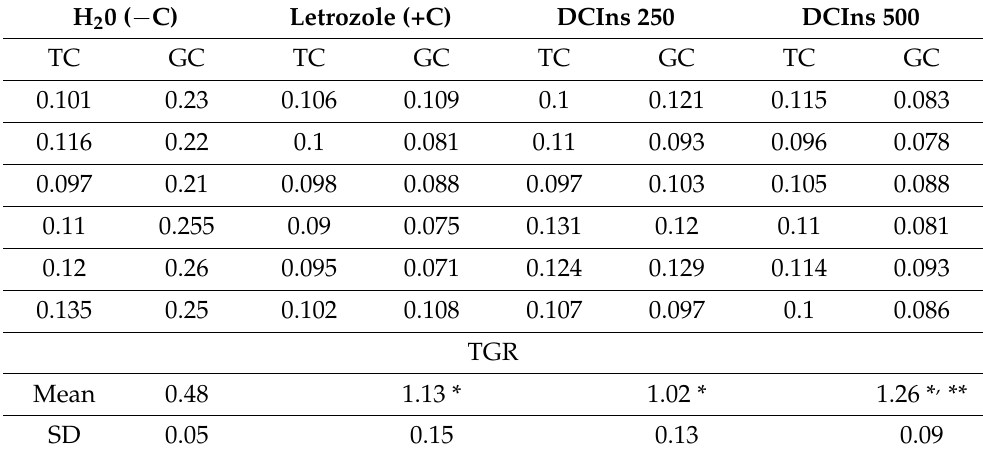
Note. Values were then converted in μ m according to a micrometer eyepiece: 0.1 unit = 9 μ m. One Way ANOVA, p < 0.001; * p < 0.01 versus H 2 O; ** p < 0.01 versus H 2 O; ** p < 0.05 versus DCIns 250.